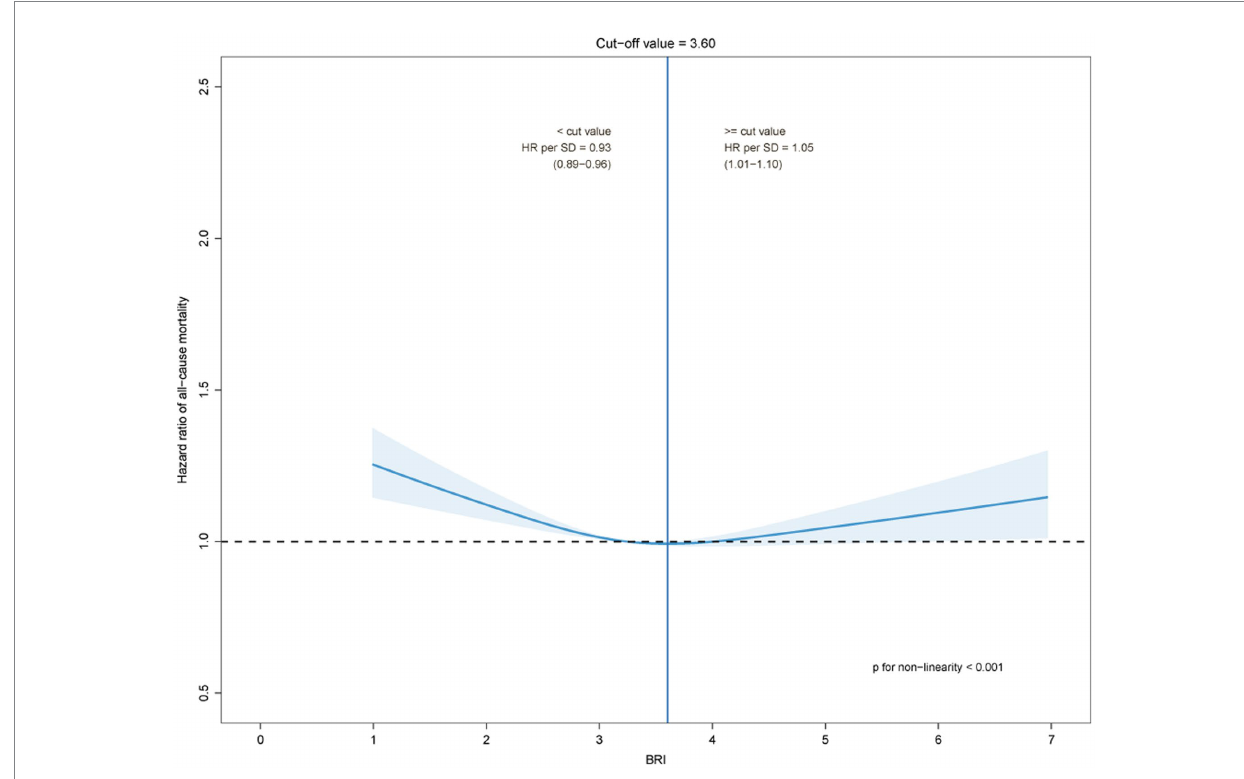
FIGURE 3 The dose–response relationships between the body roundness index and all-cause mortality by restricted cubic spline